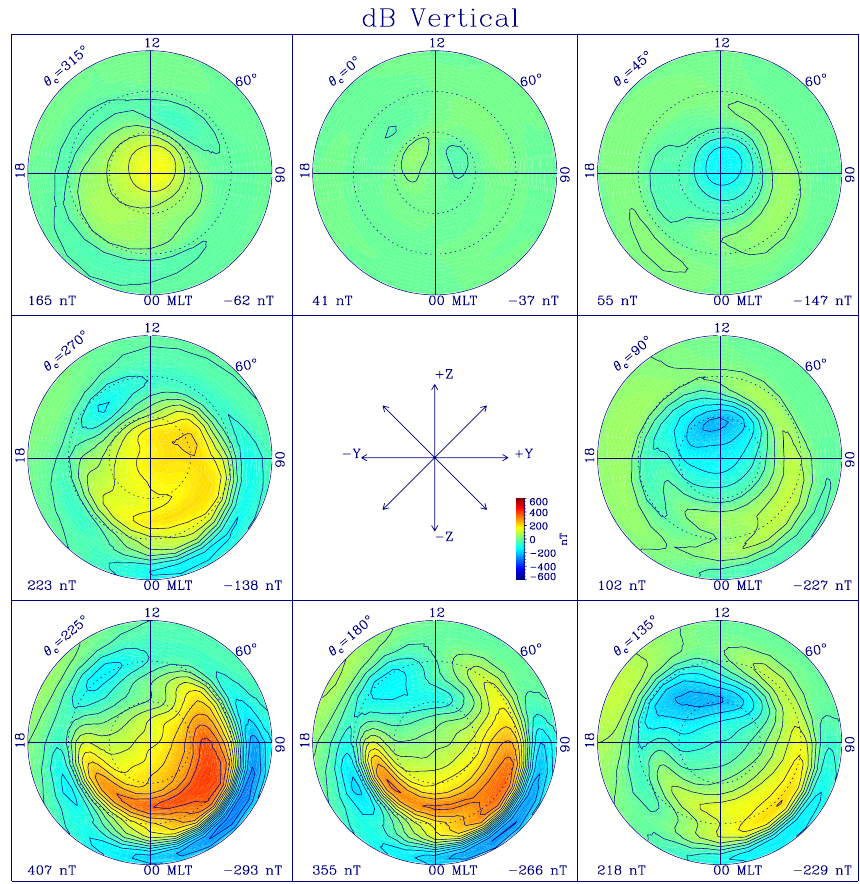
Fig. 5. Evolution of vertical component of the geomagnetic perturbations as the IMF clock angle rotates in the same format as Fig. 3. Downward is specified as